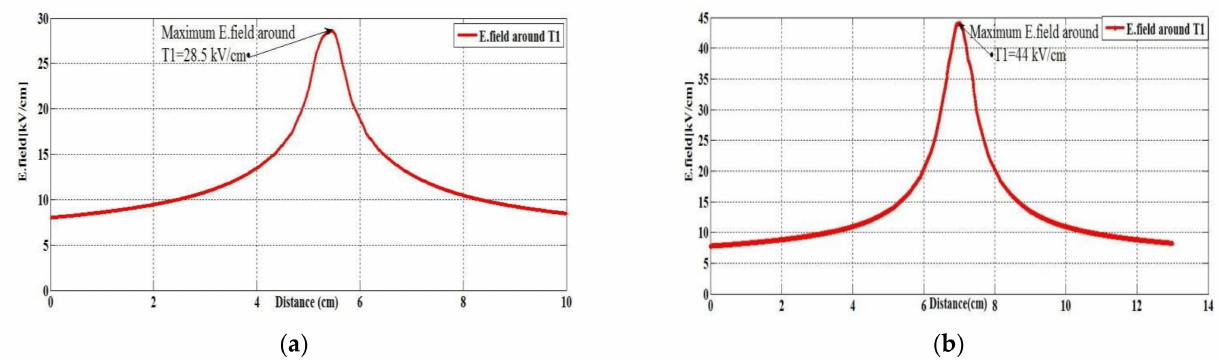
Figure 18. Probability of lightning strike on different points in a pyramid shape ( a ) field value for normal pre-breakdown conditions, ( b ) field value for upward leader